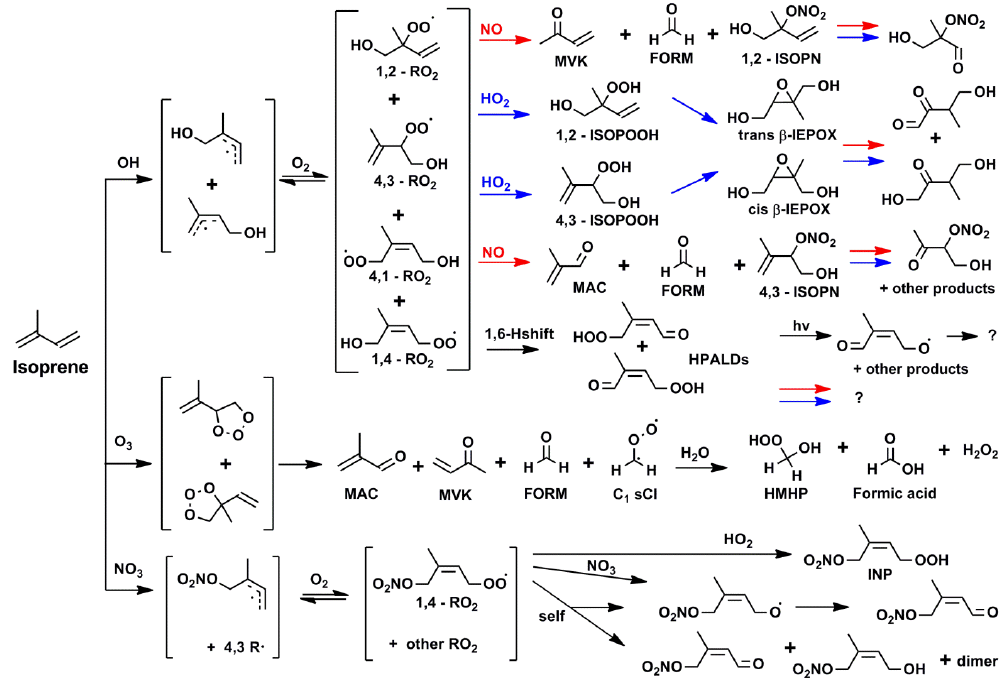
Scheme 1. Representative mechanism from the OH-, O 3 - and NO 3 -initated oxidation of isoprene. The most abundant isomers of a partic- ular pathway are shown. Red and blue arrows in the OH-oxidation scheme denote the NO-dominated and HO 2 -dominated RO 2 reactions, respectively. For the ozonolysis reaction, only the C 1 sCI and its reaction with water are shown as further-generation chemistry. For the NO 3 -oxidation pathway, only one isomer each of R and RO 2 radicals is shown for brevity. Abbreviations are defined in the